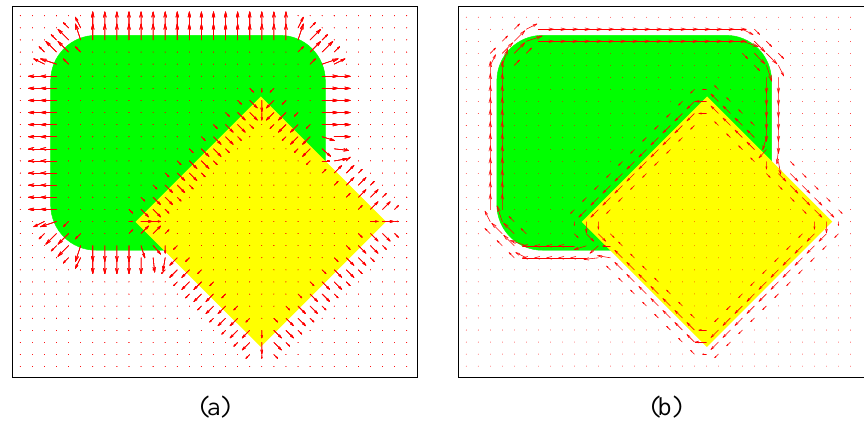
Figure 5. ( a ) a gradient-like vector field (cid:126) G obtained from Equation (11), and ( b ) an edge vector field (cid:126) e obtained from Equation